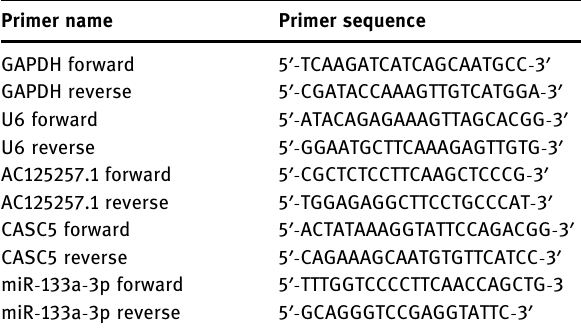
Table 2: Primers for RT -